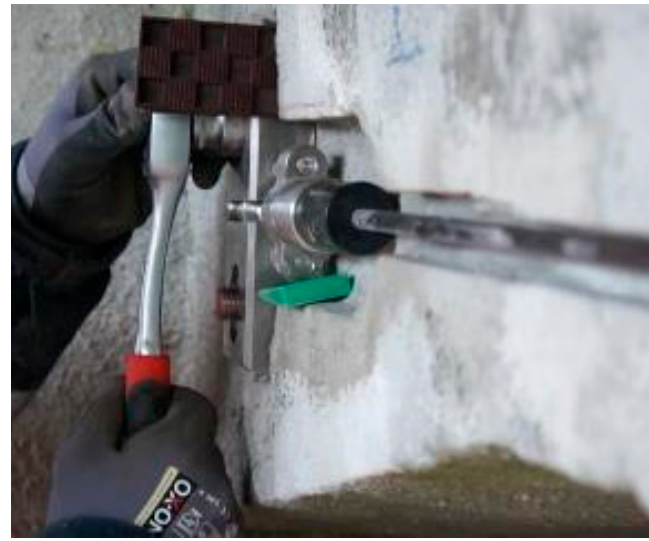
Figure 10. Installation of the through going threaded bars. Photograph by S&P.